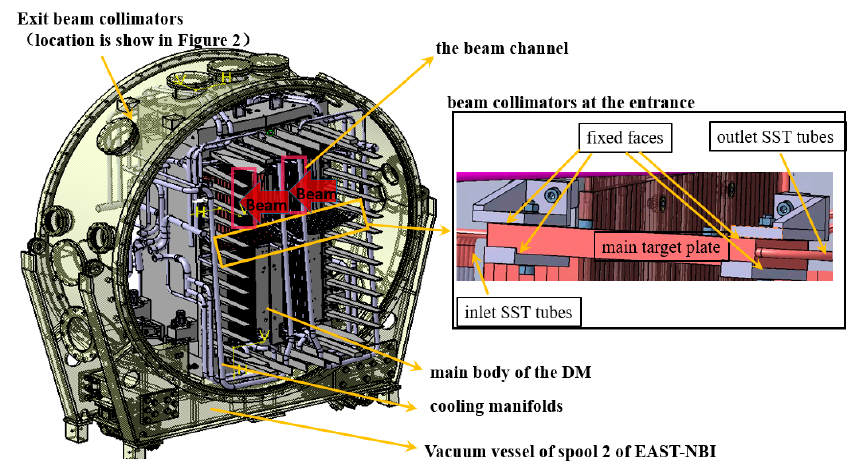
Figure 3. The redesign scheme of beam collimators for the EAST-NBI system.